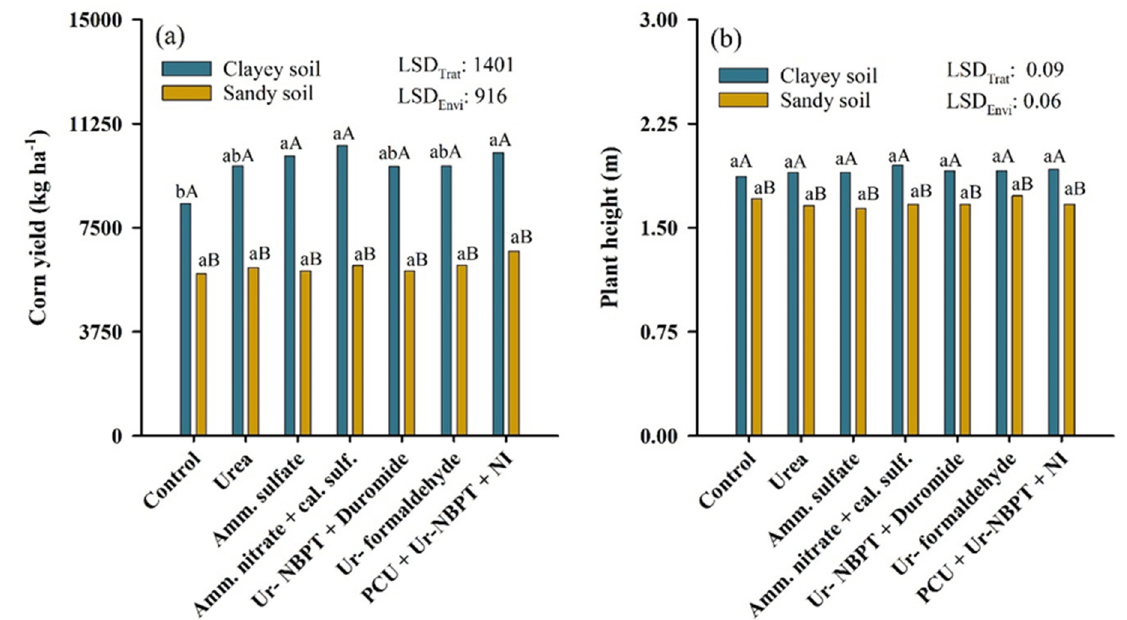
Figure 8. Corn yield ( a ) and plant height ( b ) after fertilization in topdressing with nitrogen sources urea, ammonium sulfate, ammonium nitrate + calcium sulfate, Ur-NBPT + Duromide, Ur-formaldehyde, and PCU + Ur-NBPT + NI for clayey and sand soil. Treatments followed by the same lowercase letter do not differ using a Tukey test ( p < 0.05). Environments followed by the same capital letter do not differ using a Tukey test ( p < 0.05). LSD Trat : least significant difference for treatments. LSD Envi : least significant difference for environment.